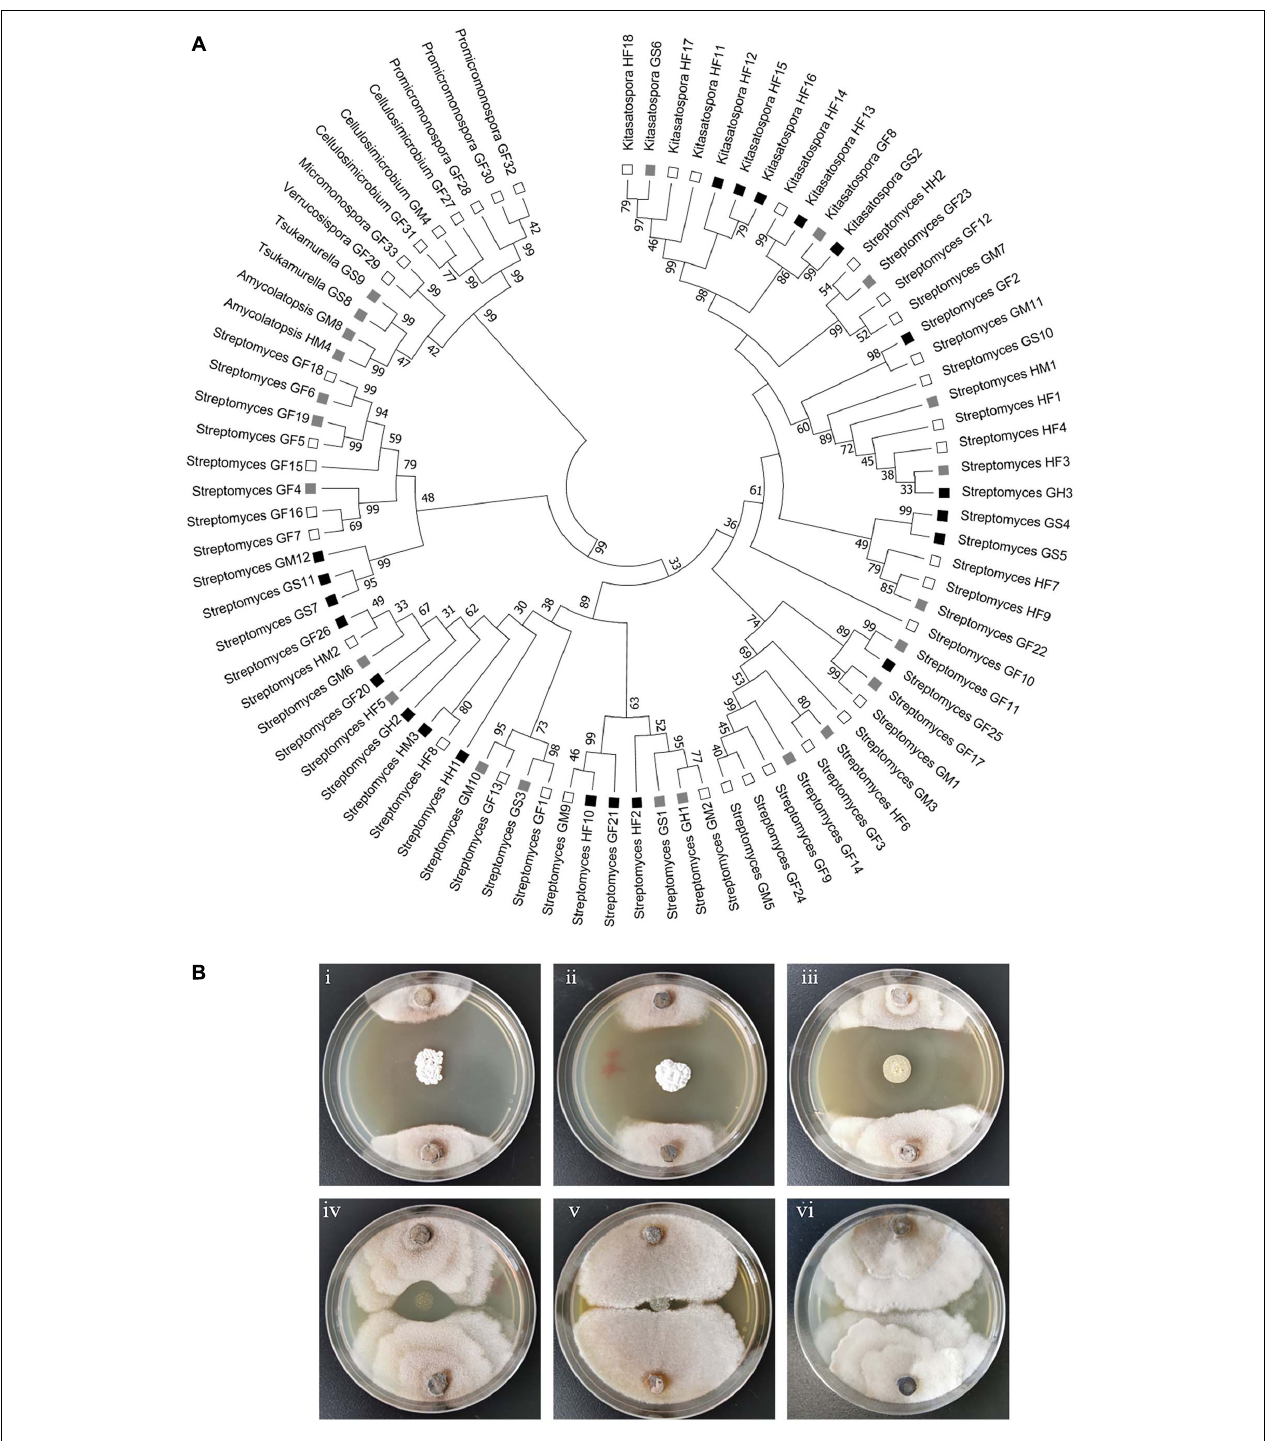
FIGURE 2 | Phylogenetic and anti- Xylaria activity analyses of the isolated actinomycetes. (A) Phylogenetic tree of all the isolated strains. The tree was constructed with Mega 7.0 by the Neighbor-Joining method. The branch values indicate bootstrap support ( > 30 are given) of 1000 replicates. The ability to inhibit the growth of Xylaria sp. is indicated with black squares (strong inhibition, ZOI > 2 cm), gray squares (moderate inhibition, ZOI = 0.5–2 cm), and open squares (little or no inhibition, ZOI < 0.5 cm) (Scott et al., 2008). HF: Hunan foregut, HM: Hunan midgut, HH: Hunan hindgut, GF: Guangdong foregut, GM: Guangdong midgut, GH: Guangdong hindgut, GS: Guangdong soldier. (B) Examination of the anti- Xylaria activity of the isolated actinomycetes by paired challenge assay. Inhibition of representative Streptomyces against Xylaria sp. is shown. (i–v) Streptomyces sp. strains against Xylaria sp. (i–iii) HF10, GS7, and GF20, strong inhibition; (iv) GM6, moderate inhibition; (v) GM1, no inhibition; (vi) control, Xylaria